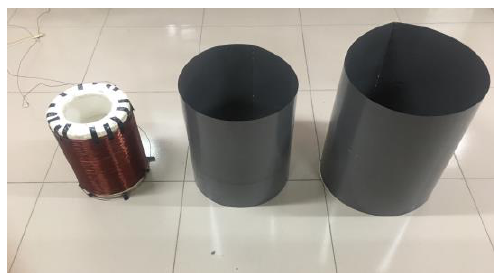
Figure 19. Position of shield.